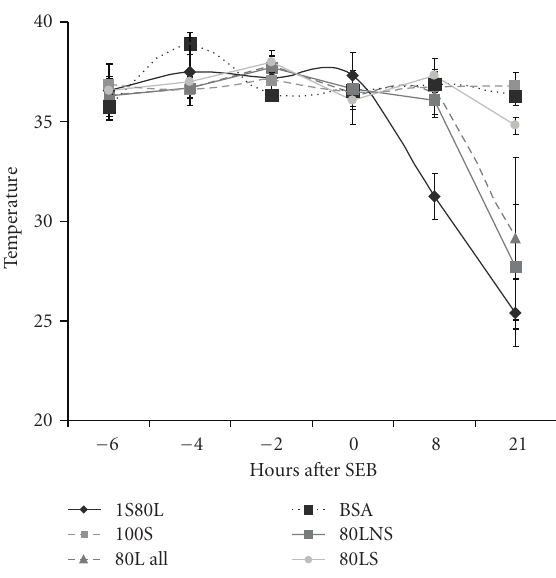
Figure 2: Temperature changes of BALB/c mice treated with 100 μ g SEB, 80 μ g LPS, 1 μ g SEB plus 80 μ g LPS, or 100 μ g of bovine serum albumin (BSA). Points represent the mean ± standard deviation (SD) for each group ( n = 10) except for survivors (80LS) and nonsurvivors (80LNS) of mice treated with 80 μ g LPS.